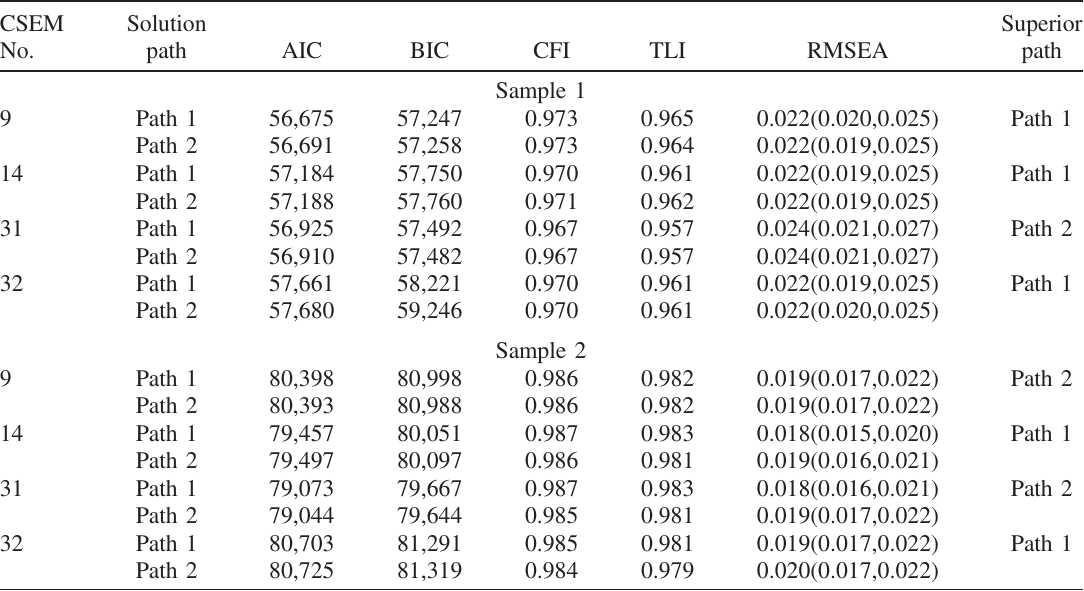
TABLE VI. Sample 1 and 2 reserved item comparisons. Differences in AIC and BIC determine whether the models are statistically different; CFI, TLI, and RMSEA indicate the quality of fit for each